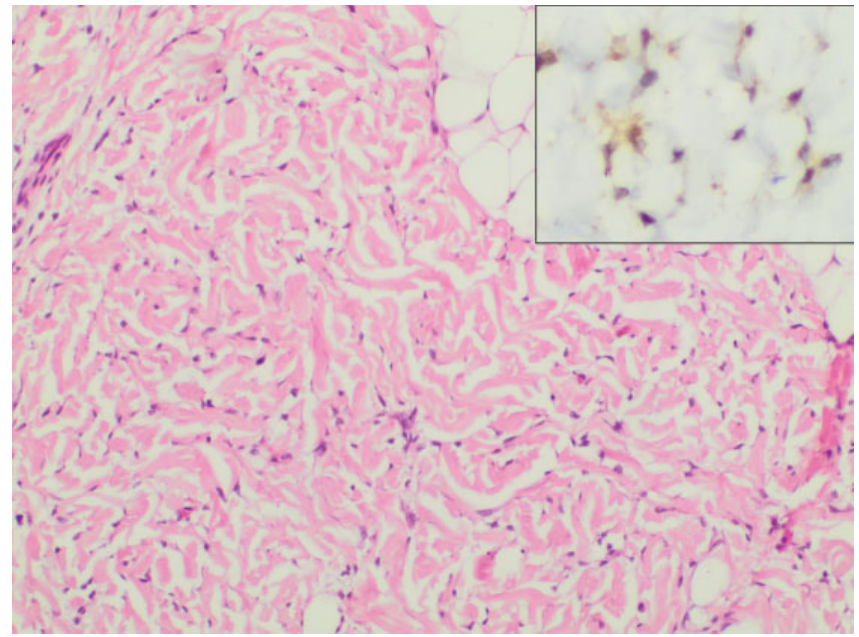
Fig. 2 Histological images of the tumor. H&E stain ( (cid:1) 40) shows thick haphazardly arranged collagen bundles with few interspersed spindle cells of fi broblast type. Insert shows positive immunohistochemistry staining of β -catenin in the tumor ( (cid:1) 100). H&E, Hematoxylin and eosin. (Image courtesy of A. Kaiser, MD, Klinikum Nürnberg, Institute of Pathology).